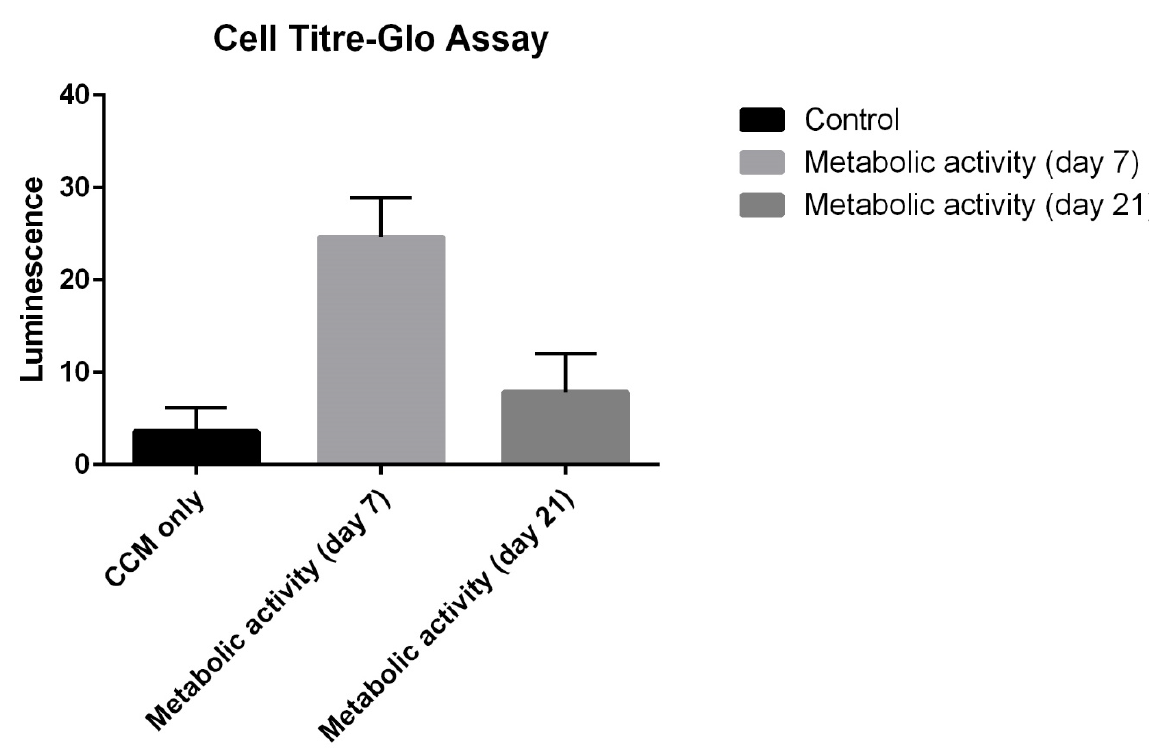
Figure 8. Cell Titre-Glo Metabolic assay. The cultured cells had a high metabolic activity a week post culture and this reduced by 21 days post culture. Even at 21 days, the cultured cells demonstrated metabolic